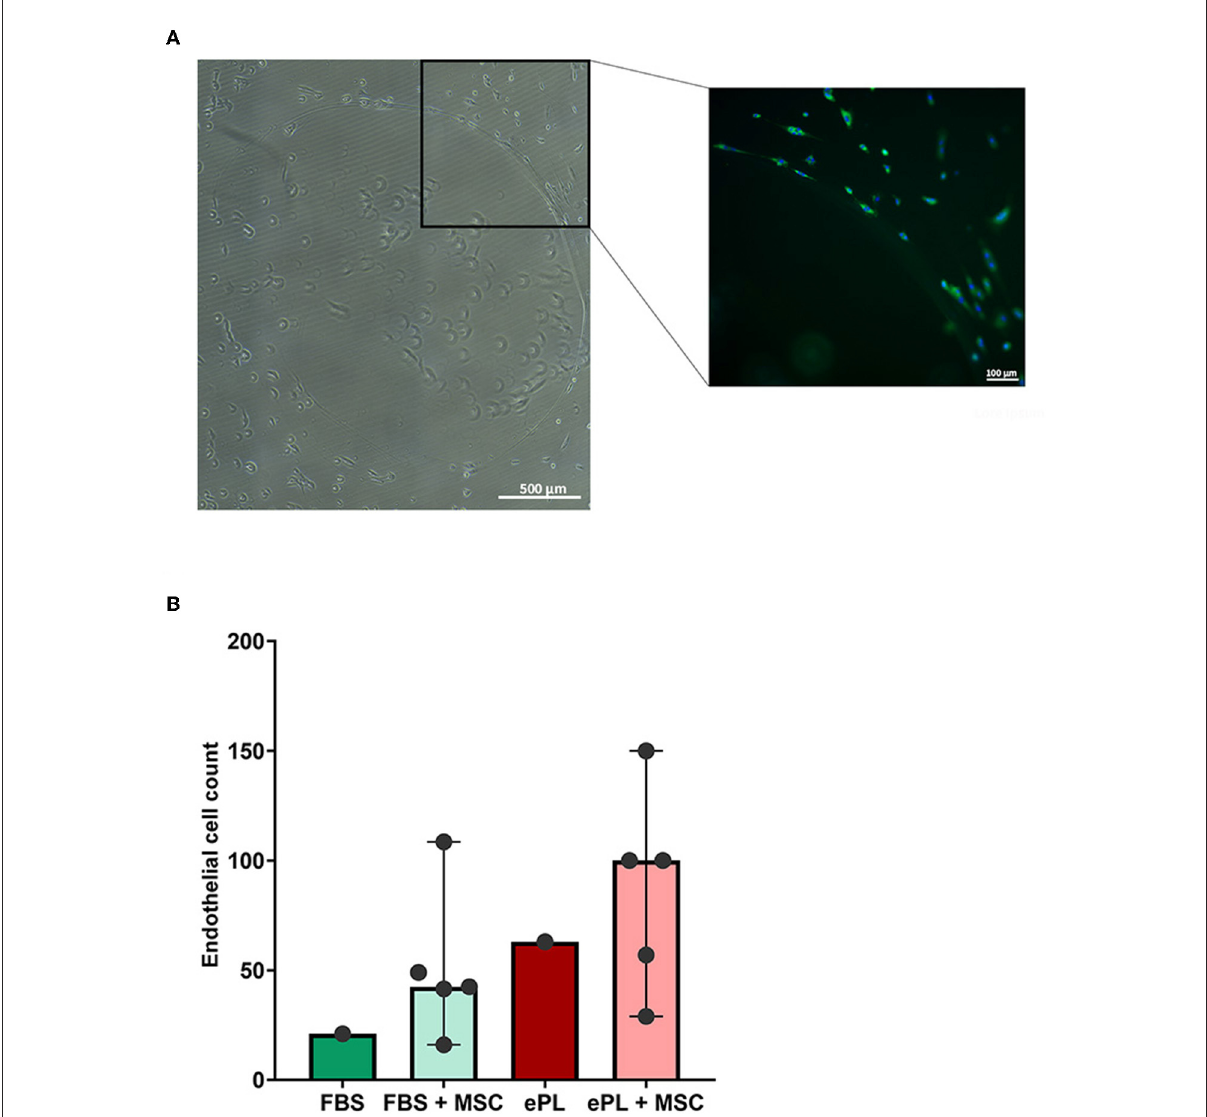
FIGURE5 Images of equine endothelial cells displaying the formation of a vessel-like structure (A), which was only observed in co-culture with mesenchymal stromal cells (MSC) and with 10% equine platelet lysate (ePL) medium and ePL matrix. To the left, a stitched phase contrast image is displayed. The image to the right presents the corresponding merged fluorescence microscopy image after lectin (green) and DAPI (blue) staining. The diagram (B) shows the endothelial cell counts per field of view, determined by quantitative analysis of the images obtained after co-culture with MSC. For the groups in which biological replicates in the form of co-culture with MSC from different donors were available, bars display the median values and error bars the 95% confidence intervals. Endothelial cells from n = 1 donor were co-cultured with MSC from n = 5 donors; differences were not statistically